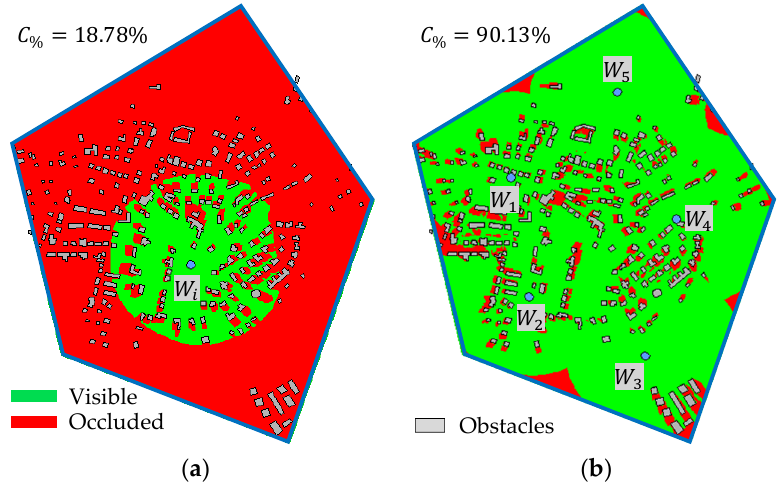
Figure 3. Visible points in the area of interest: ( a ) single waypoint; ( b ) multiple waypoints.